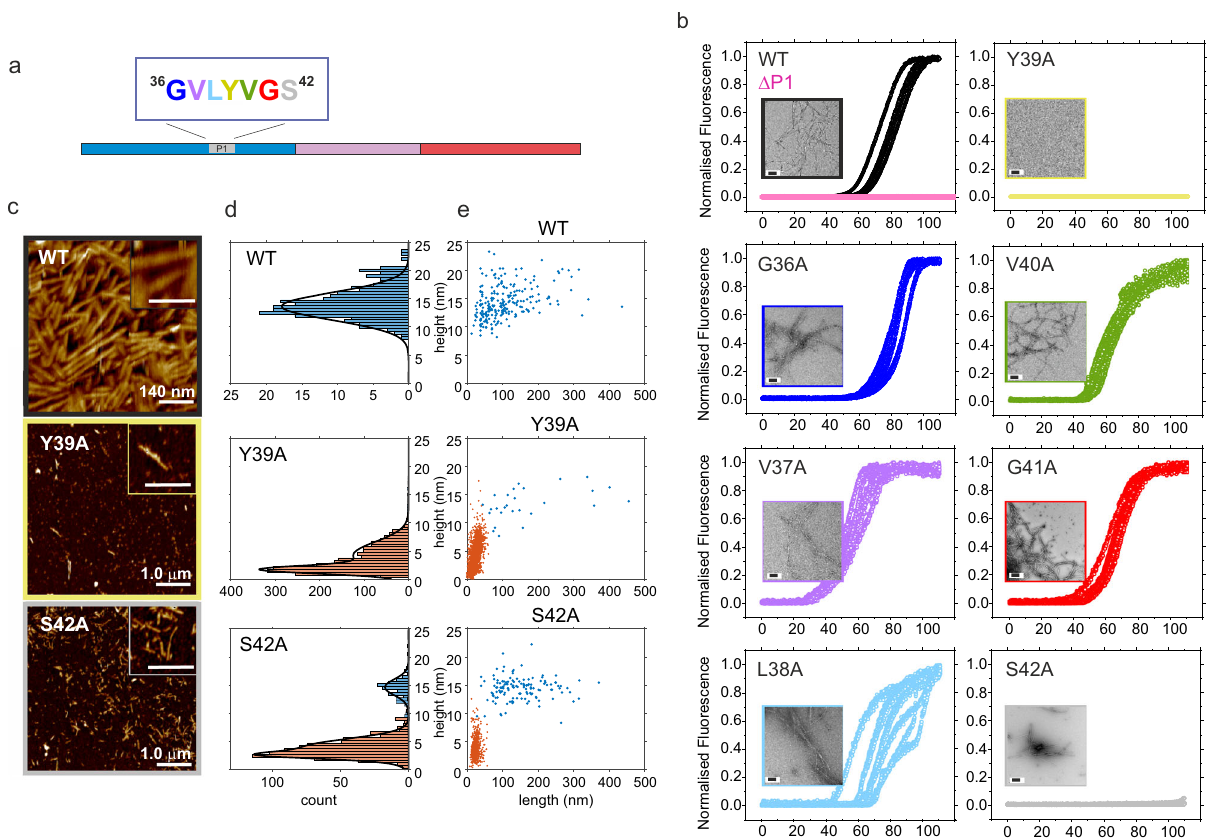
Fig. 5 | Alanine scan to identify residues in P1 region important for amyloid formation.a Schematicshowingthe sequenceof theP1regionof α Syn. b Amyloid kineticsofthesevenAlavariantsintheP1regionof α Syndeterminedusing100 μ M α Syn at 37°C, 20mM Tris-HCl, 200mM NaCl, pH 7.5, 600rpm, coloured as in a . Data for WT α Syn and Δ P1 are shown for comparison. Inserted are representative TEM images taken at the end point of one biological replicate ( n =2). Scale bar= 200nm. Further images for Y39A and S42A are shown in Supplemental Fig. 5. c AFMimagesof WT α Syn(top),Y39A(middle)andS42A(bottom)attheendpoint